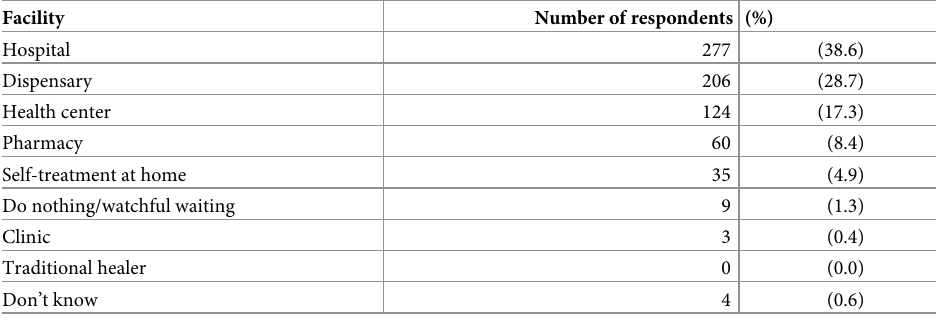
Table 3. Responses to the question ‘Where would you seek care if you or another adult in your household had chest pain?’ among adults in northern Tanzania, 2018 (N = 718).